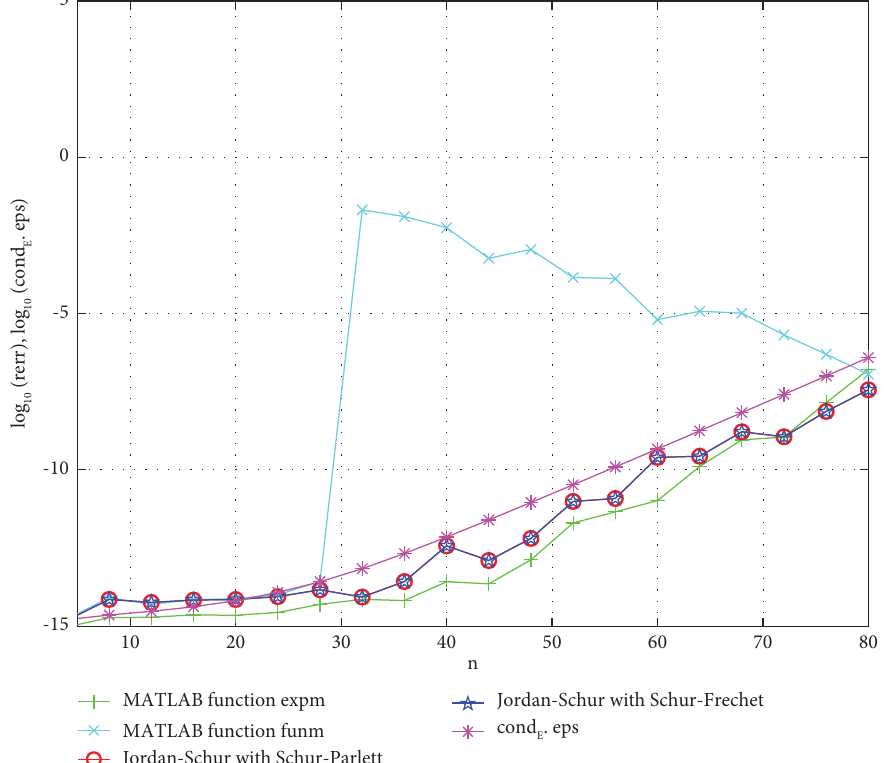
Figure 4: Relative errors for Experiment